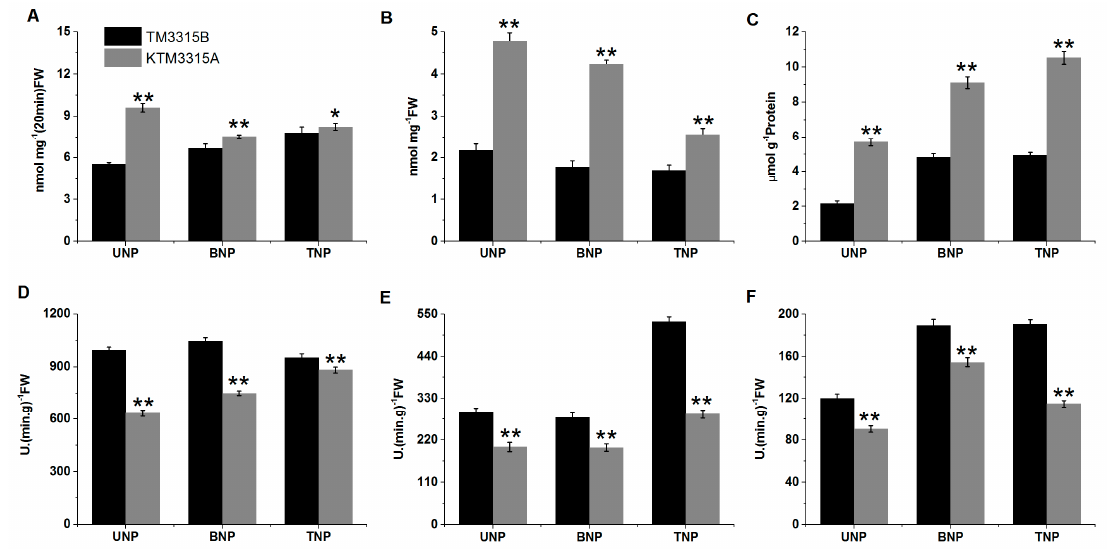
Figure 9. The O 2 − production rate ( A ), H 2 O 2 ( B ) and MDA ( C ) contents and activities of superoxide dismutase (SOD) ( D ), peroxidase (POD) ( E ) and catalase (CAT) ( F ) in developing anthers. Data represent the mean ± standard deviation based on three independent experiments. Significant differences were determined using the Student’s t -test (* p < 0.05, ** p < 0.01). UNP, uninucleate stage; BNP, binucleate stage; TNP, trinucleate stage.